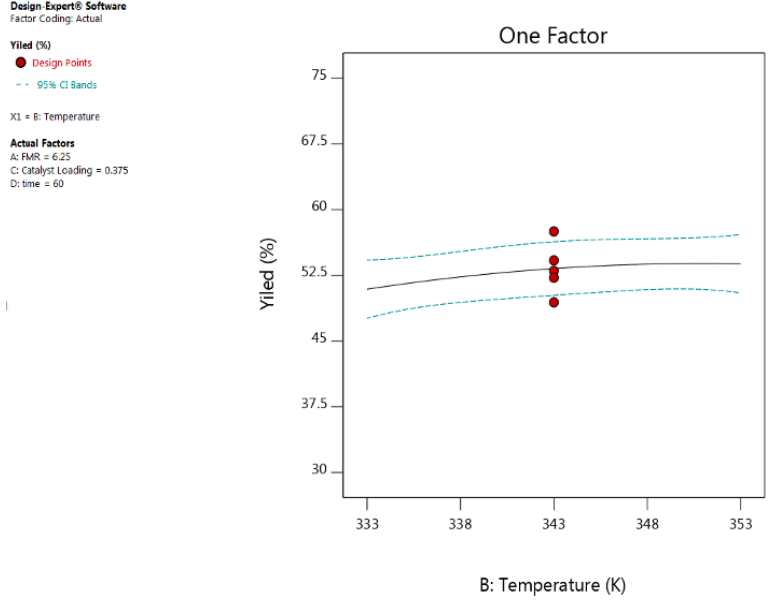
Figure 7. The effect of reaction temperature on the yield of 1,2-epoxy-5-hexene.